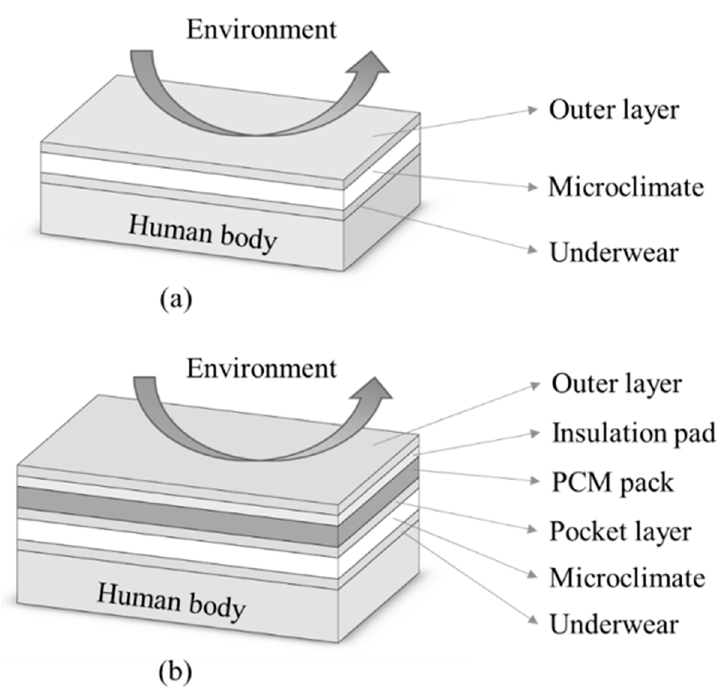
Figure 2. Configurations of clothing-body segments ( a ) without and ( b ) with PCMs and insulation pads considered for the numerical model.